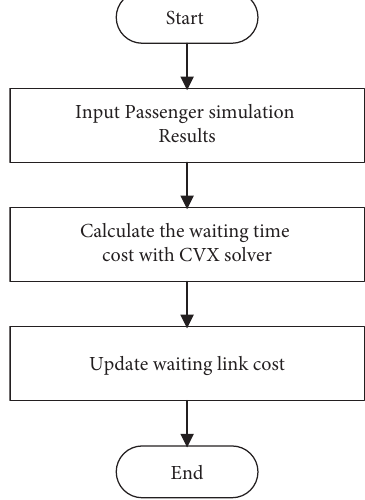
Figure 4: Updating process for waiting